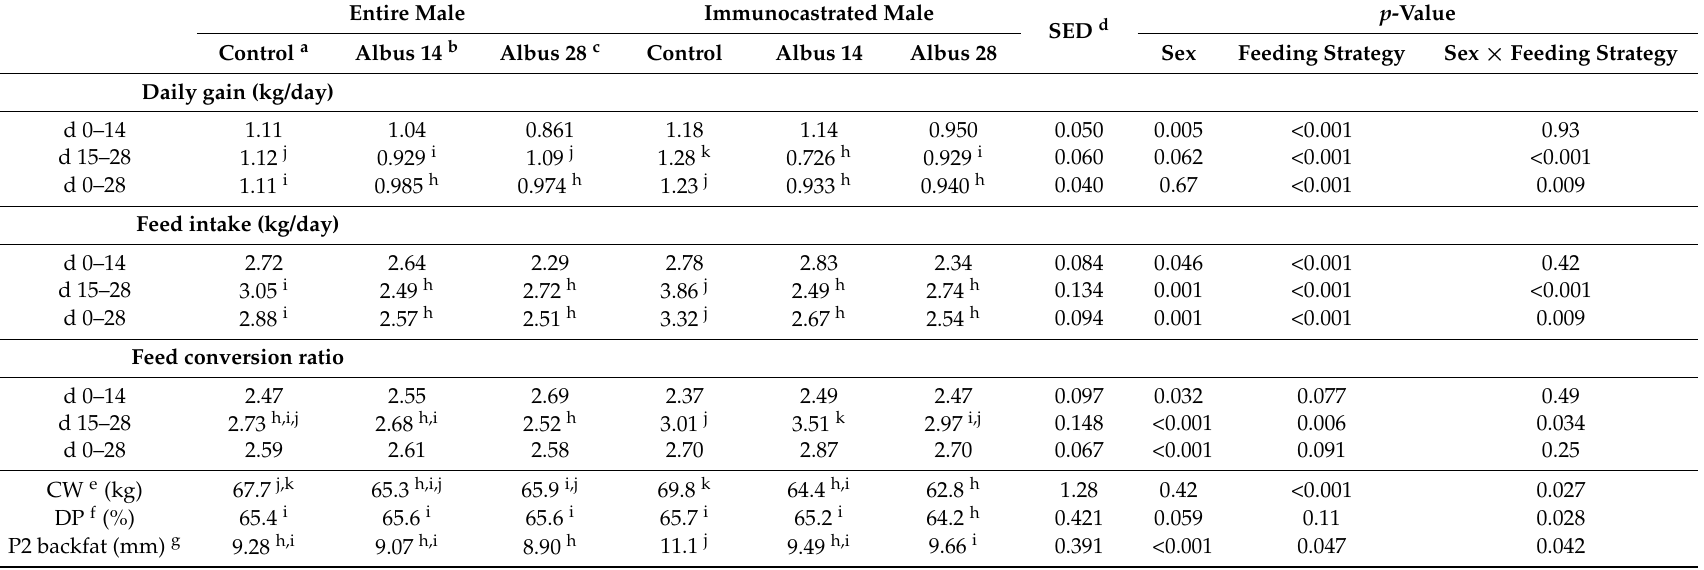
Table 4. Growth and carcass performance for entire male and immunocastrated male pigs fed three different feeding strategies from 72.3 to 101.1 kg liveweight ( n = 7). p -Value Entire Male Immunocastrated Male SED d Albus 14 b Albus 28 c Control Albus 14 Albus 28 Sex Feeding Strategy Sex × Feeding